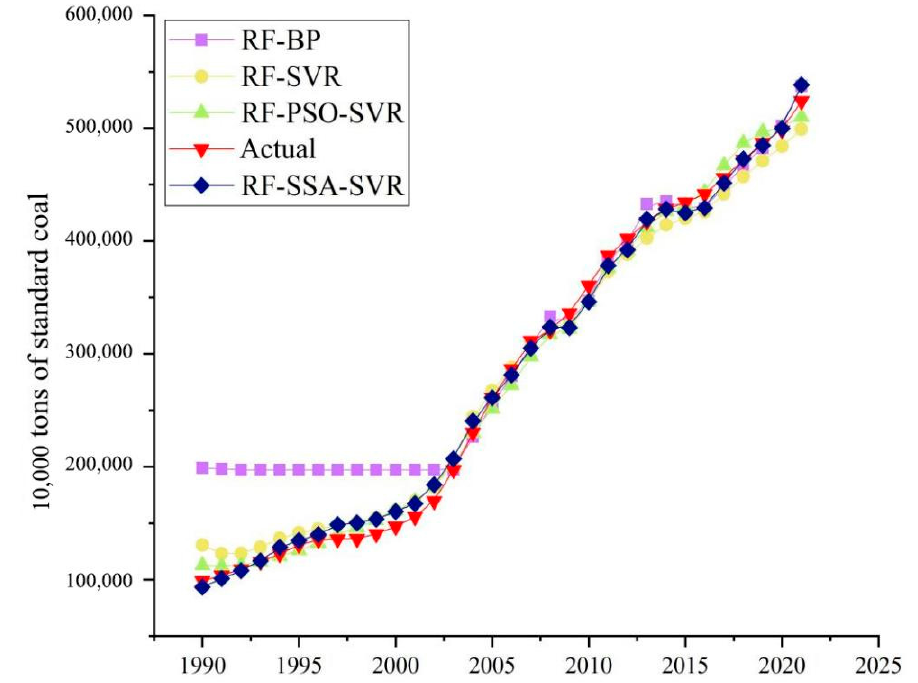
Figure 3. Prediction comparison chart.